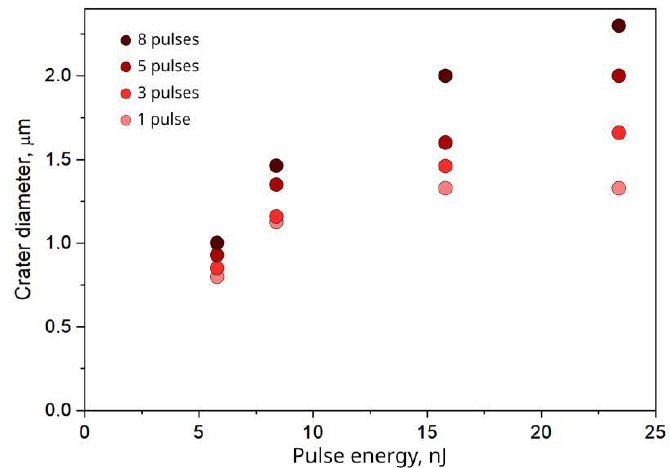
Figure 3. Dependence of crater diameter on pulses of energy E = 5.8, 8.4, 15.8, and 23.4 nJ and numbers of pulses N= 1, 3, 5, 8. For each energy, four diameter values corresponding to pulse numbers N = 1, 3, 5, and 8 are given (from bottom to top).